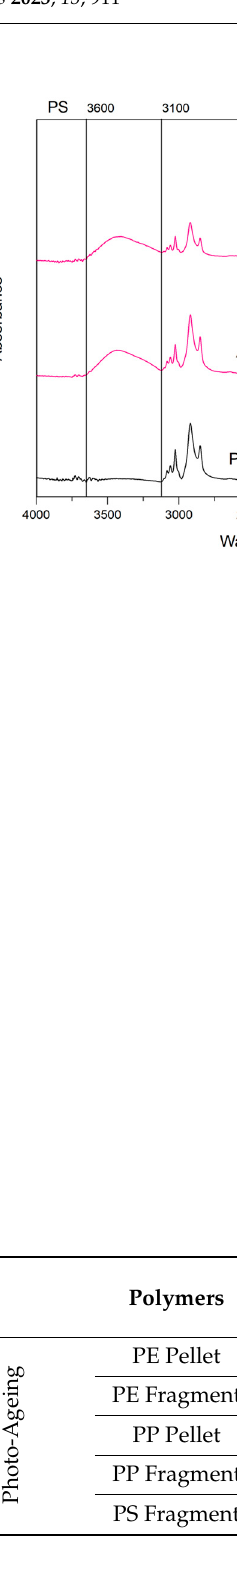
Table 3. Comparison of CI, HI, and COI calculated for each polymer. Values are expressed as an average of two replicates ± standard deviation ( Ds ) after 15 and 20 days of exposure to UVA rays in a climate room.